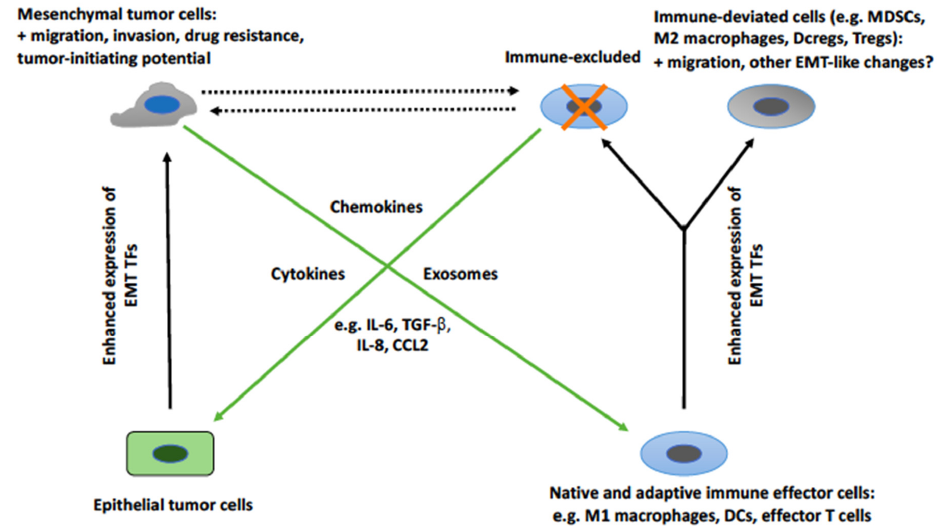
Figure 1. The relationship between changes induced by EMT tumor cells in cells of the immune system and the induction of tumor cell EMT by cells of the immune system. EMT tumor cells induce changes in cells of the immune system that promote their exclusion or deviation toward protumorigenic phenotypes. The mediators of these changes are cytokines, chemokines, or exosomes. At least part of these mediators induce both changes, possibly through the activation of a similar set of EMT transcription factors. Moreover, some of the changes that affect tumor cells and cells of the immune system are similar, such as enhanced migration. The dashed lines indicate an as yet unexplored aspect of this relationship, i.e., the possibility that EMT tumor cells and deviated immune cells regulate each other. Abbreviations: CCL, C-C motif chemokine ligand; DC, dendritic cell; DCreg, regulatory DC; EMT, epithelial-mesenchymal transition; IL, interleukin; MDSC, myeloid-derived suppressor cell; TGF, transforming growth factor; TF, transcription factor; Treg, regulatory T cell.